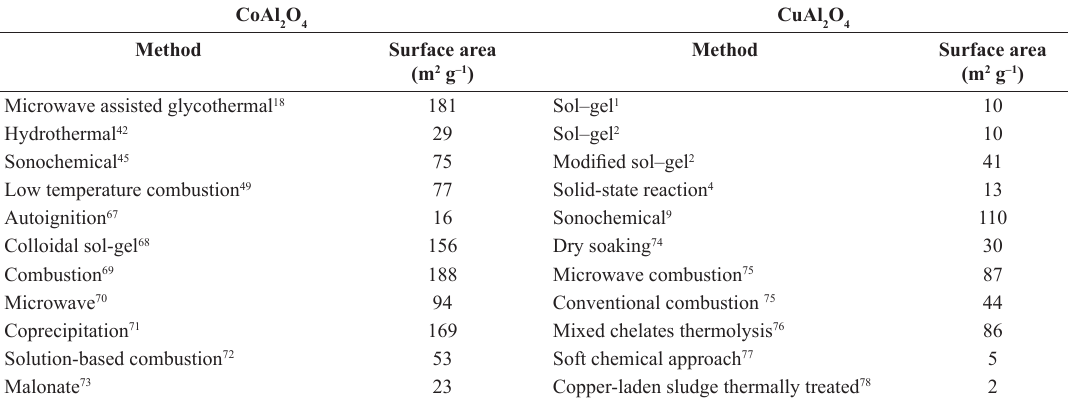
Table 2. Comparing the surface area values of different synthesis methods found in the literature.